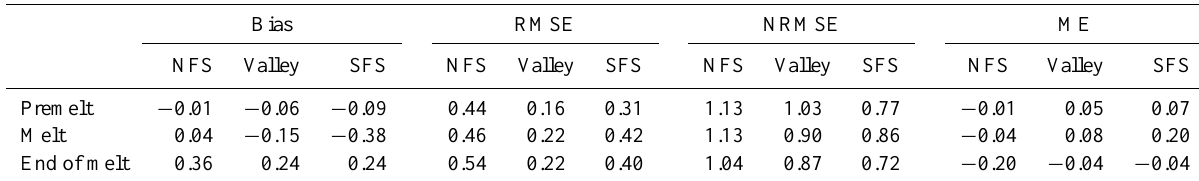
Table 3. Coupled model bias, mean error, root mean square (rms) and rms errors normalized by the standard deviation of measured snow depths, for snow depths on the three dominant topographical units and at different stages of the melt season (Premelt=21 April; Melt=25 April, 28 April, 3 May and 7 May; End of Melt=10 May, 16 May and 19 May. Only one of the three transects was surveyed on the last two dates). ME and RMSE are in metres.